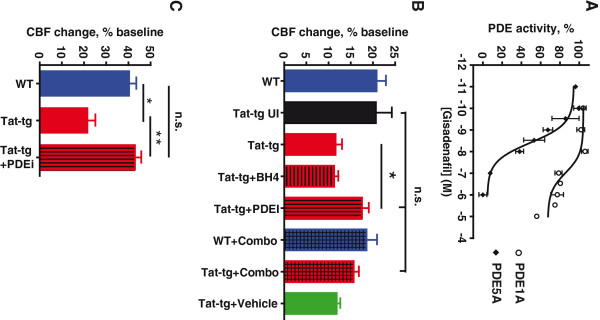
Phosphodiesterase 5 inhibition restores vasodilatory function in Tat-transgenic mice. (A) Specificity of gisadenafil as demonstrated by measuring phosphodiesterase (PDE) activity in lysates of Cos7 cells overexpressing either PDE1A or PDE5A. (B). Maximum cerebral blood flow (CBF) reached in response to 30-second exposure to 6% CO2, as measured by laser Doppler flowmetry. The data for the untreated wild type (WT) and Tat-tg and WT mice are taken from Figure
1 (C, D); they are included here for comparison purposes. Number of animals: three for Tat-tg+BH4, five for Tat-tg + PDE5 inhibitor gisadenafil (PDEi), three for WT treated with combination of BH4 and PDEi, three for Tat-tg treated with drug combination, four for Tat-tg injected with vehicle. (C). Maximum CBF reached in response to 5-minute exposure to 6% CO2. The data for the untreated WT and Tat-tg and WT mice are taken from Figure
1 (A, B); they are included here for comparison purposes. **P <0.01, *P <0.05; n.s., not significant, nonparametric permutation test. All data represent mean ± SEM